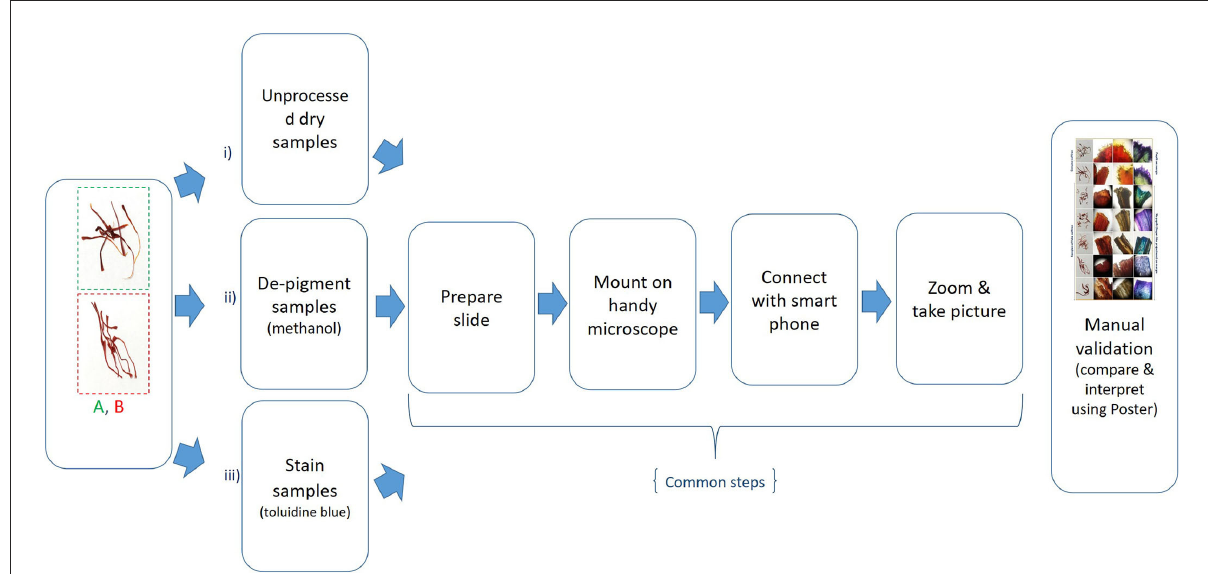
FIGURE3 Poster-based validation: (i) Dry samples are used as such (without any chemical treatment) and then common downstream steps, as shown above, are followed; (ii) samples are de-pigmented using methanol first, and then common downstream steps are followed; (iii) samples are stained using toluidine blue, and then common downstream steps are